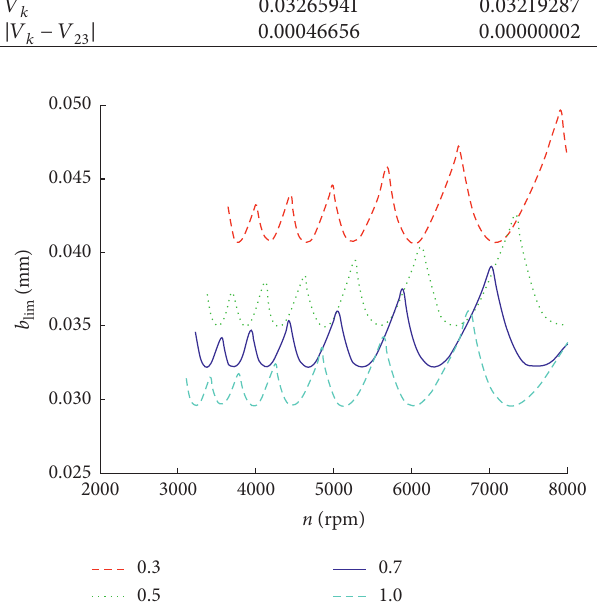
Figure 8: Effect of the taper ratio on chatter stability.